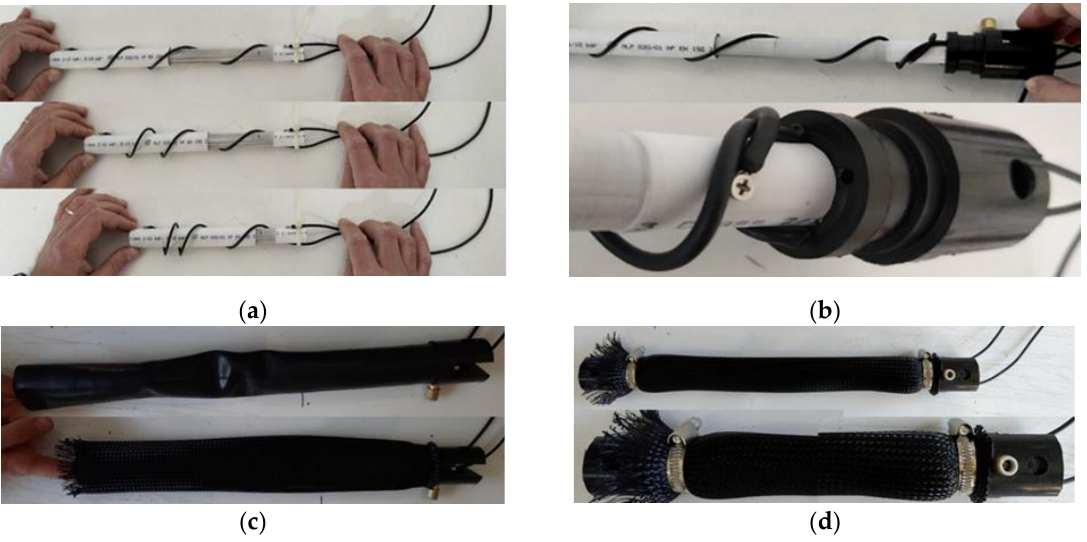
Figure 8. Steps for the assembly procedure of the proposed MKM: ( a ) assembly of the capacitive transducer and wrapping of one shielded cable; ( b ) assembling of the capacitive transducer and the cables to the complex end; ( c ) assembling of the hyper-elastic tube and the braided gauze; ( d ) the assembled prototype of the MKM and details of the two ends.